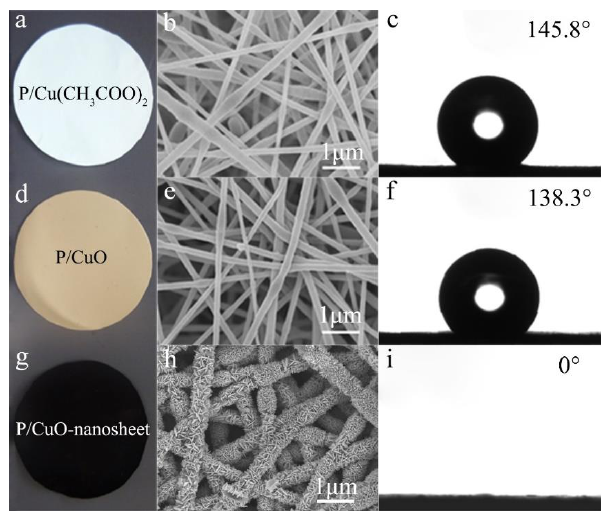
Figure 2. The optical image of ( a ) P/Cu(CH 3 COO) 2 , ( d ) P/CuO, and ( g ) P/CuO-nanosheet membranes; the morphology of ( b ) P/Cu(CH 3 COO) 2 , ( e ) P/CuO, and ( h ) P/CuO-nanosheet membranes; the wettability of ( c ) P/Cu(CH 3 COO) 2 , ( f ) P/CuO, and ( i ) P/CuO-nanosheet membranes.